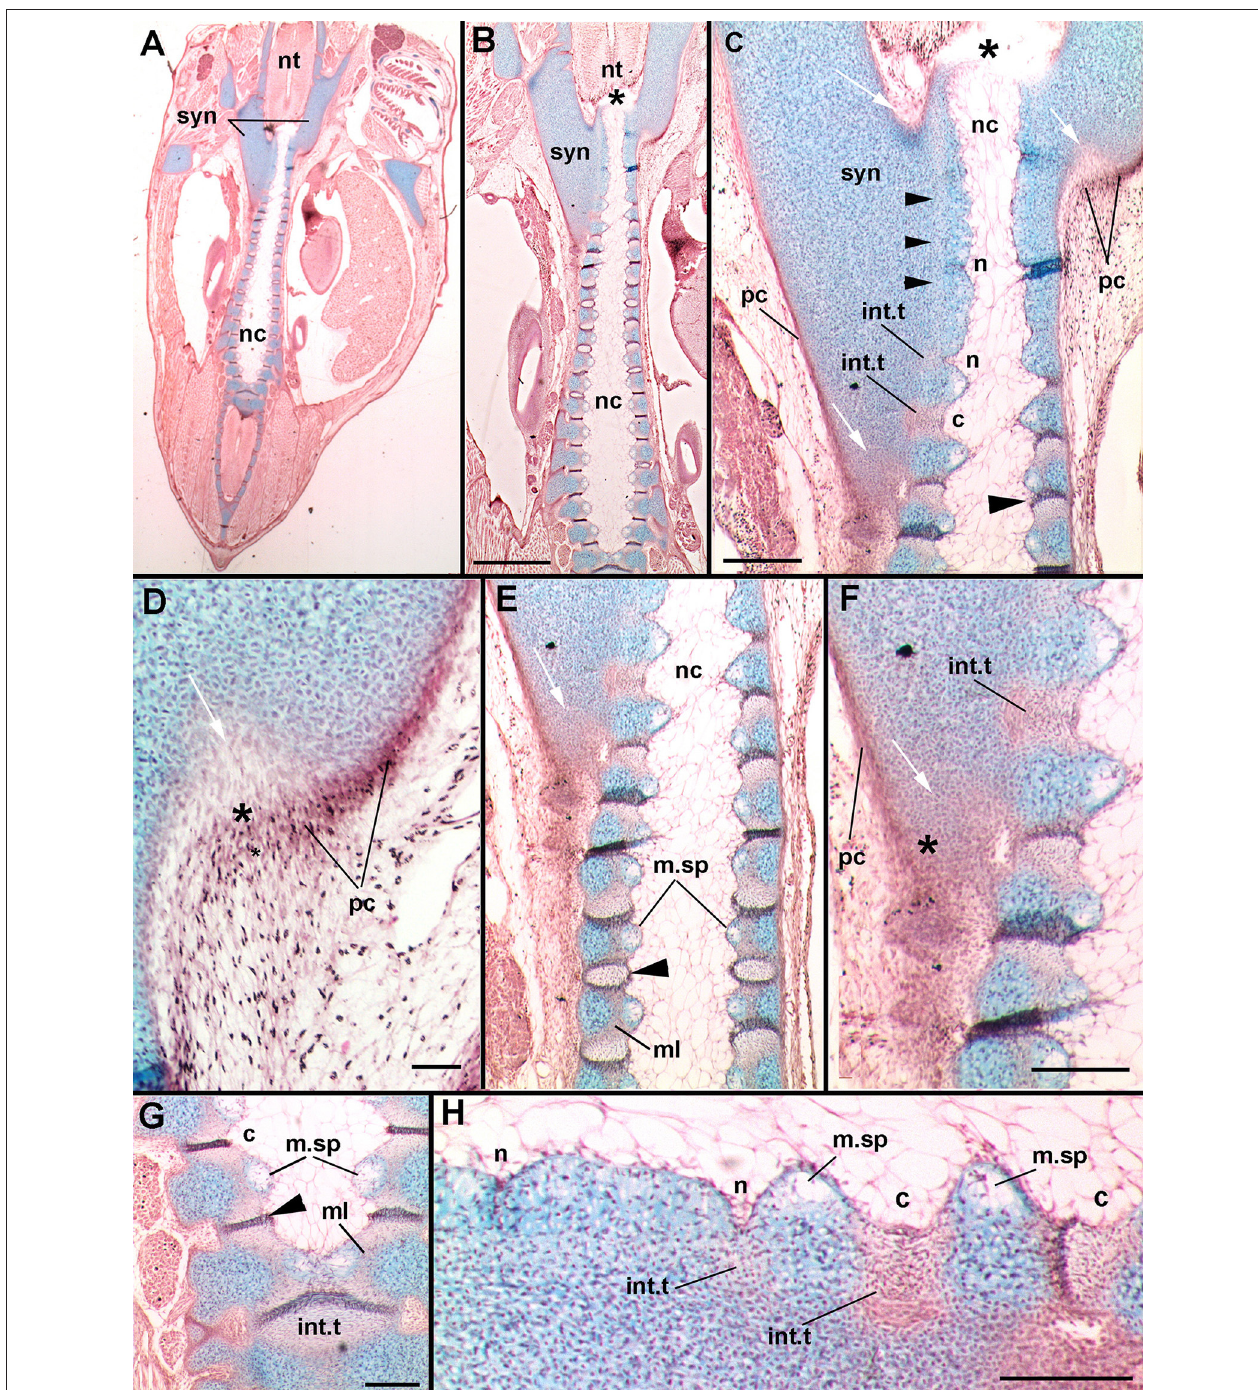
FIGURE 6 | Leucoraja erinacea , st. 31, horizontal histological sections, stained with alcian blue, haematoxylin, and eosin. (A) overview of vertebral column and synarcual; (B) closeup of posterior synarcual and separate vertebral column (central axis); (C) closeup of posterior synarcual and anterior vertebral axis, white arrows indicate developing cartilaginous cells (also C–F) black arrowhead indicates developing intervertebral tissue; asterisk in (B,D) indicates anterior end of central vertebral axis; (D) , closeup of area indicated in (C) ; (E) closeup of posterior synarcual and central vertebral axis, black arrowhead indicates developing intervertebral tissue; (F) closeup of area indicated in (E) ; (G) more posterior central vertebral axis, showing medial spaces and intervertebral tissues fusing to become single units, black arrowhead indicates developing intervertebral tissue; (H) closeup of anterior vertebral axis indicated in (C) rotated, showing developing notches (developing into intervertebral tissue) and protrusions (developing into centra). Abbreviations as in Figures 1 – 4 , also: c, concavity; ml, middle layer; m.sp, medial space; n, notch; pc, perichondrium. Scale bars: (B,C,F–H) = 2mm; (D) = 0.05mm.